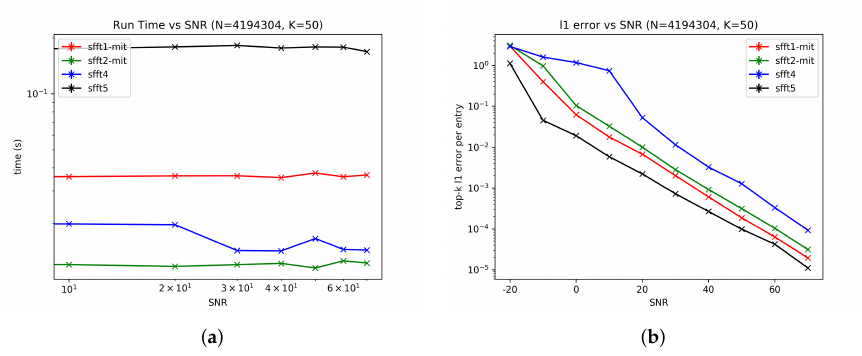
Figure 5. The run time and L 1 -error vs. SNR. for the sFFT1.0, sFFT2.0, sFFT4.0 and sFFT5.0 algorithms in the general sparse case. ( a ) run time vs. SNR; ( b ) L 1 -error vs.